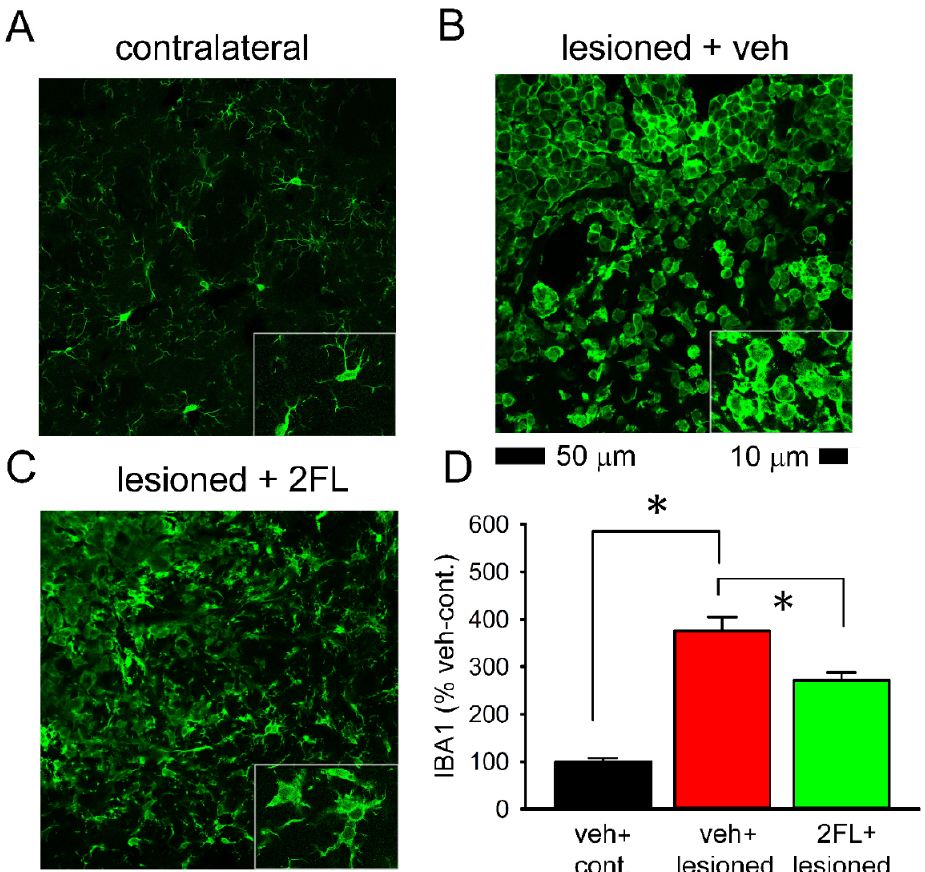
Figure 3. Early post-treatment 2FL reduced microglial activation in the lesioned striatum. Animals received vehicle or 2FL after collagenase injection from days 1 to 5. Animals were sacrificed on day 5. Enhanced IBA1 immunoreactivity with de-ramified morphology was found in the lesioned striatum ( B vs. A ). Treatment with 2FL reduced IBA immunoreactivity ( C vs. B ). ( D ) 2FL significantly reduced IBA1 immunoreactivity in the lesioned brain. * p < 0.05, one-way ANOVA + NK